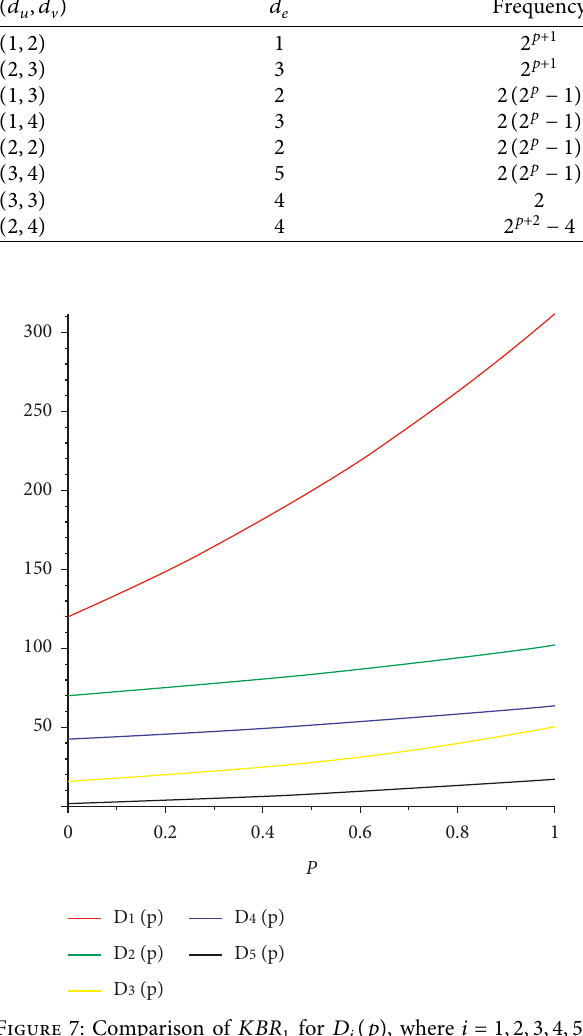
for D i ( p ) , where i � 1 , 2 , 3 , 4 , 1